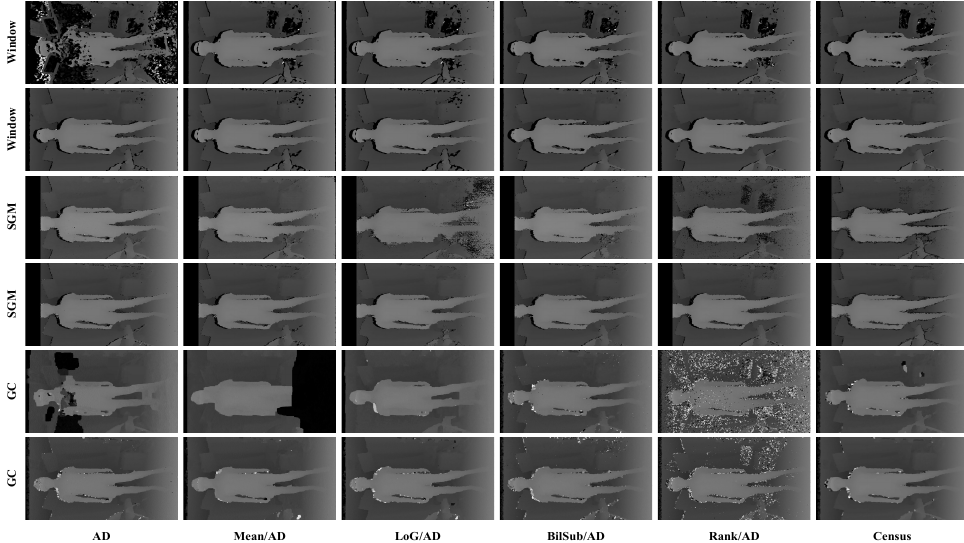
Figure 30. Estimated real disparity images of the combinations of cost and image filter using each stereo matching method, according to the pattern contrast parameter. The upper line indi- cates the low parameter, and the lower line indicates the high parameter for each stereo matching method, respectively.